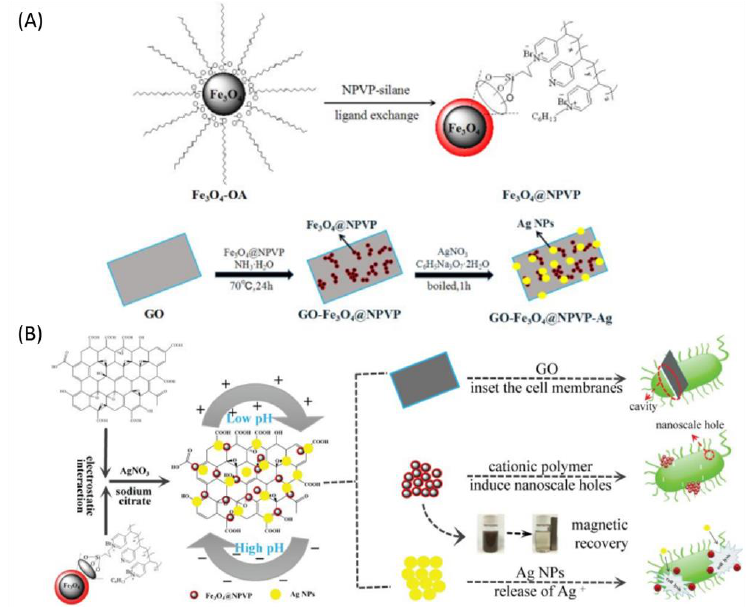
Figure 6. ( A ) Schematic representation for the preparation of GO-Fe 3 O 4 @NPVP-Ag. Reproduced from from [228], with permission from Elsevier, 2018. ( B ) Antibacterial mechanism of action [228] , with permission from Elsevier, 2018. ( B ) Antibacterial mechanism of action of GO- Fe 3 O 4 @NPVP-Ag against E. coli . Reproduced from Reference [228] , with permission from Elsevier,